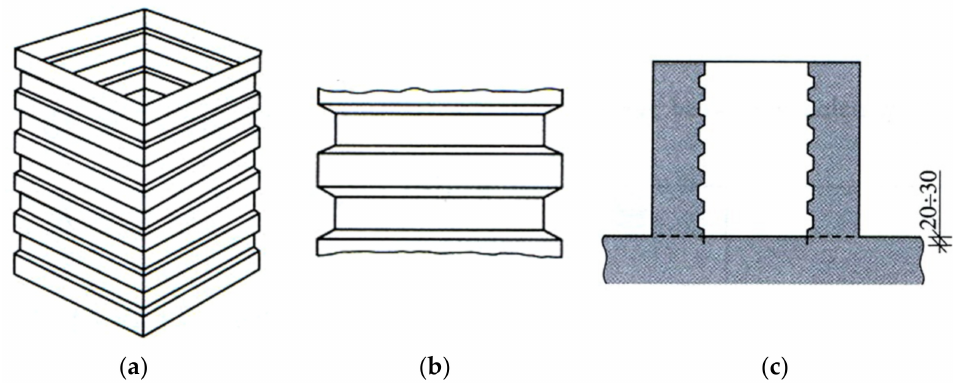
Figure 8. Metal insert forming the inside of the pocket: ( a ) view of the insert, ( b ) detail of the shape of the keyed, ( c ) placing the insert in the foundation, adapted from Ref. [65]; dimensions in mm.